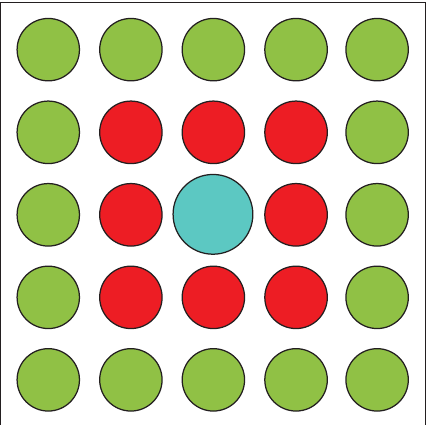
Figure 2: PSBT single subchannel test comparison (thimble means a central subchannel close to an unheated thimble).